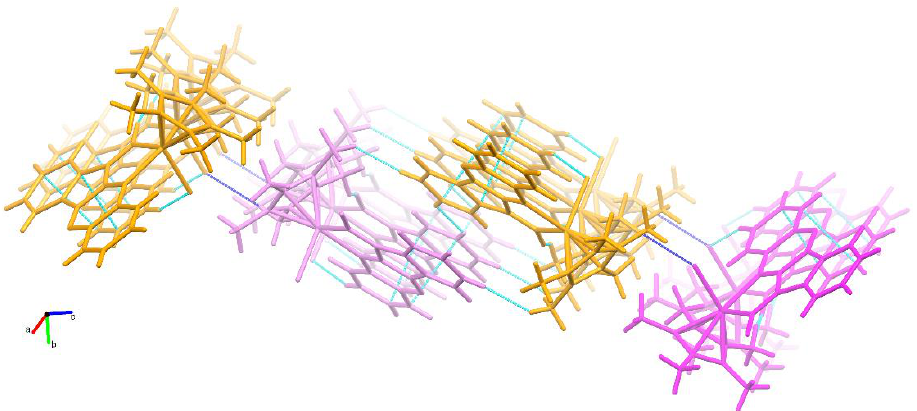
Figure 3. Fragment of the crystal structure of compound 1 showing the supramolecular interactions between the homochiral chains. Short contacts are shown as dashed lines. Enantiomeric chains are colored orange ( R -) and magenta ( S -).